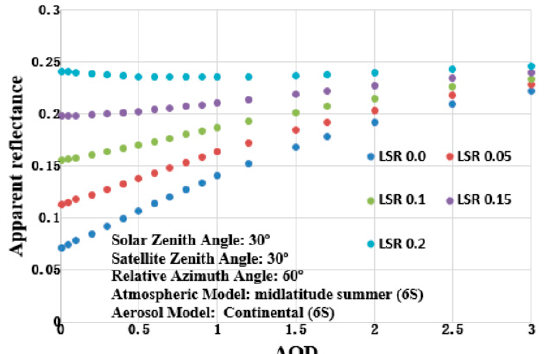
Figure 7. The change of simulated apparent reflectance in GF-1/WFV blue band with AOD and LSR.